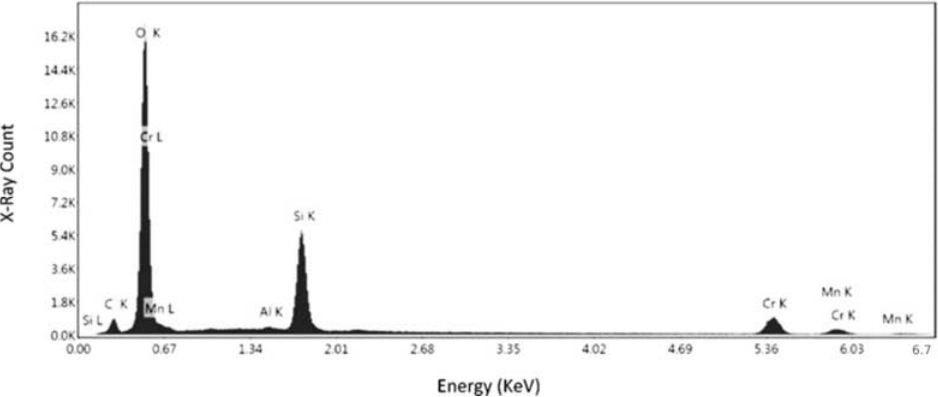
Figure 13. EDS measurement of the first point for specimen No. 5. Table 5. Chemical composition as the result of EDS analysis in specimen No. 5 (first point).